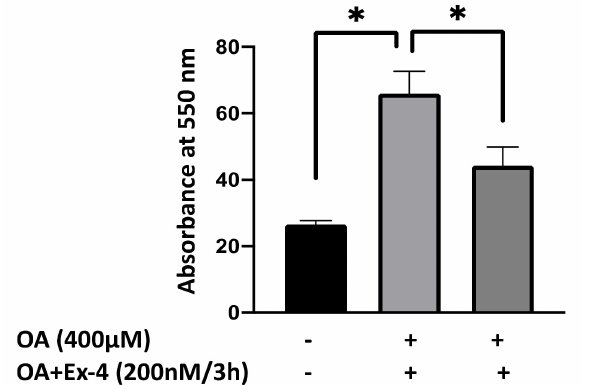
Figure 1. Oil Red O staining of lipid droplets and quantification of lipid accumulation. HepG2 cells treated with 400 µ M OA show increased staining for Oil Red O, indicating lipid accumulation intracellularly. The quantification of lipid accumulation in HepG2 cells treated with OA for 16 h, followed by treatment with 200 nM Exendin-4 for 3 h. The means were compared using Student’s t -test. The values are mean ± SEM. Statistical significance was considered at p < 0.05. The results are the average of four experiments for each condition. * indicates p <